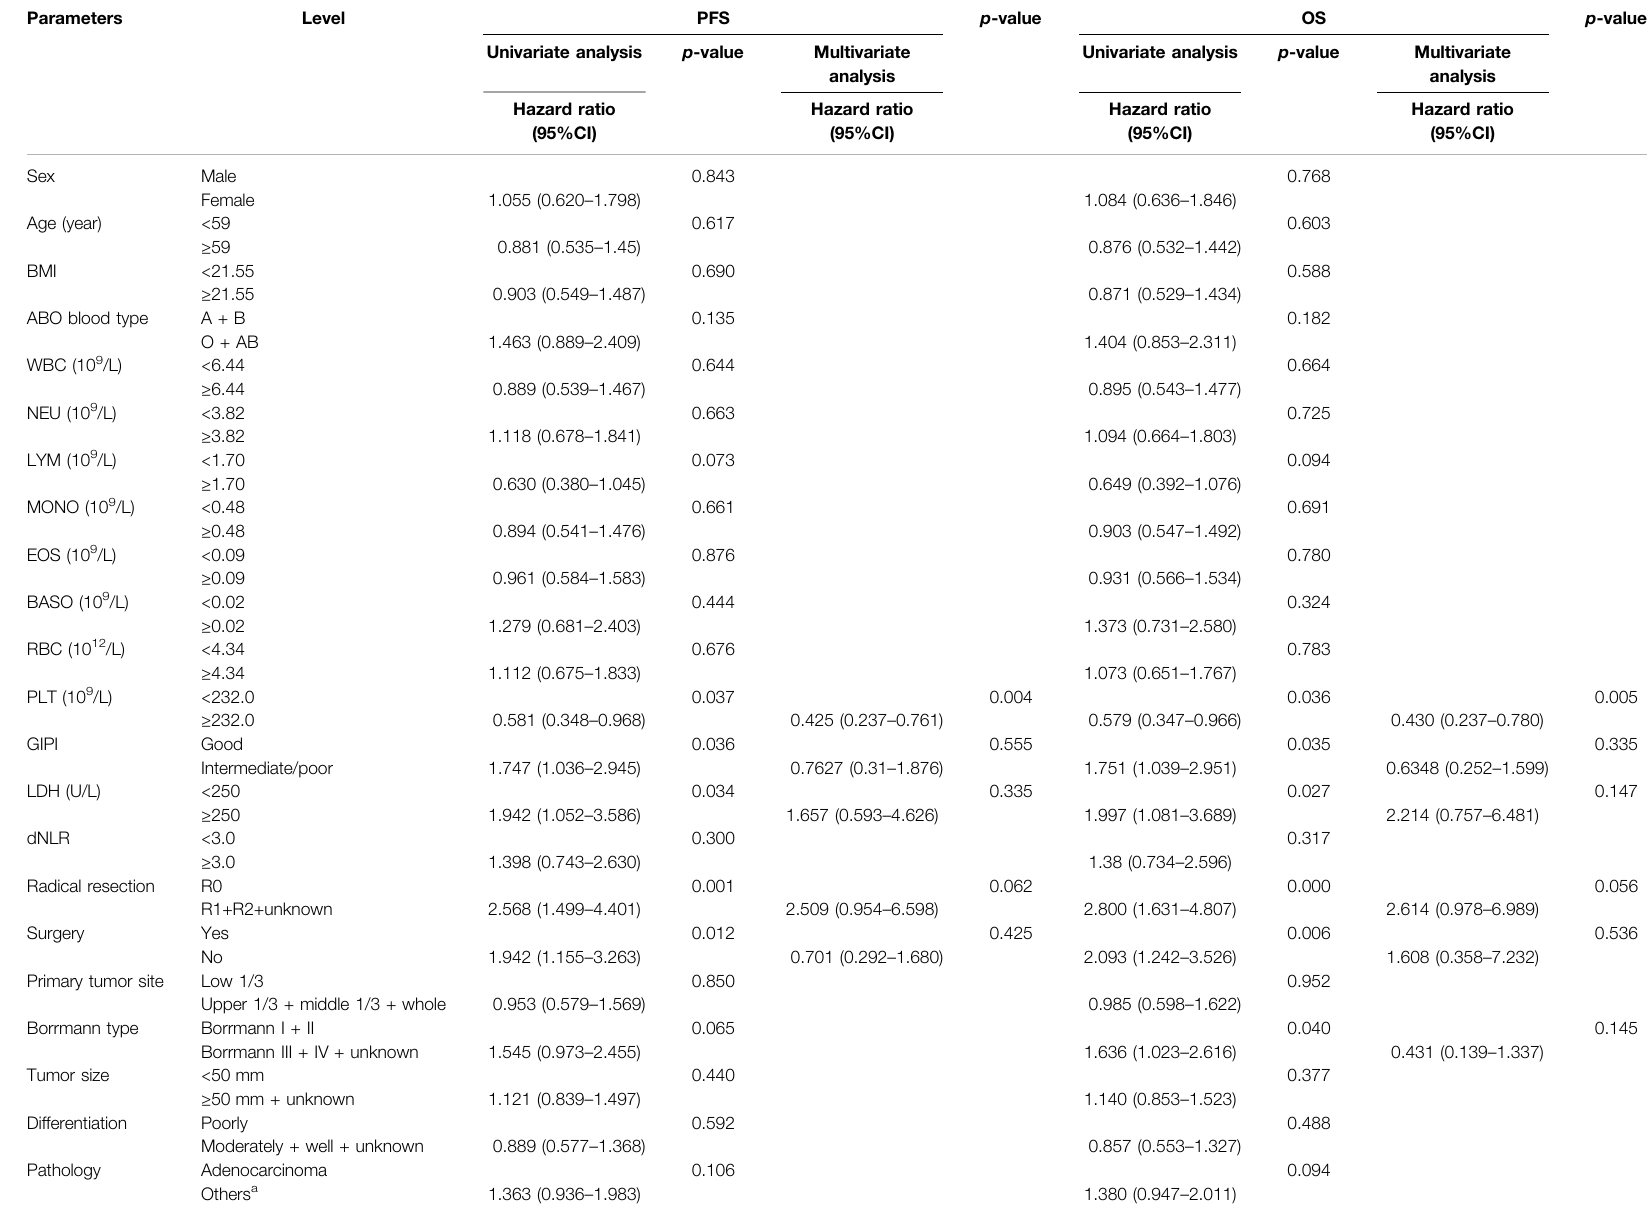
TABLE 3 | Univariate and multivariate Cox hazard analysis of biomarkers for progression-free survival (PFS) and overall survival